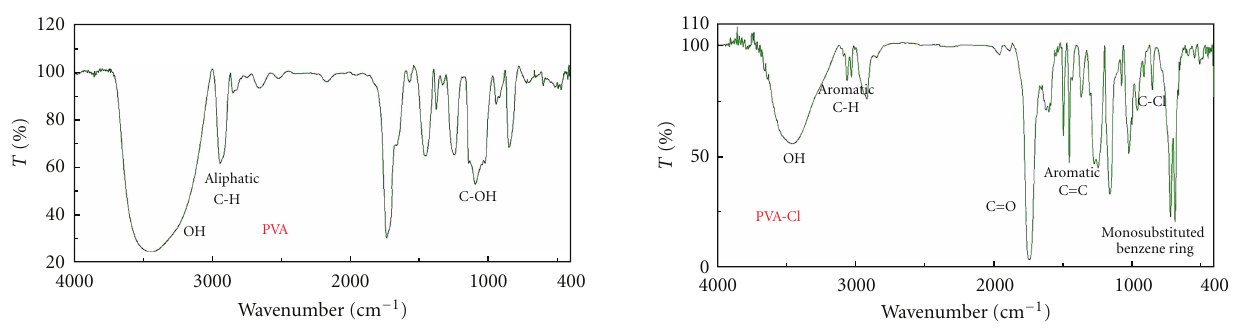
Figure 1: FTIR spectrums of PVA. Figure 2: FTIR spectrums of